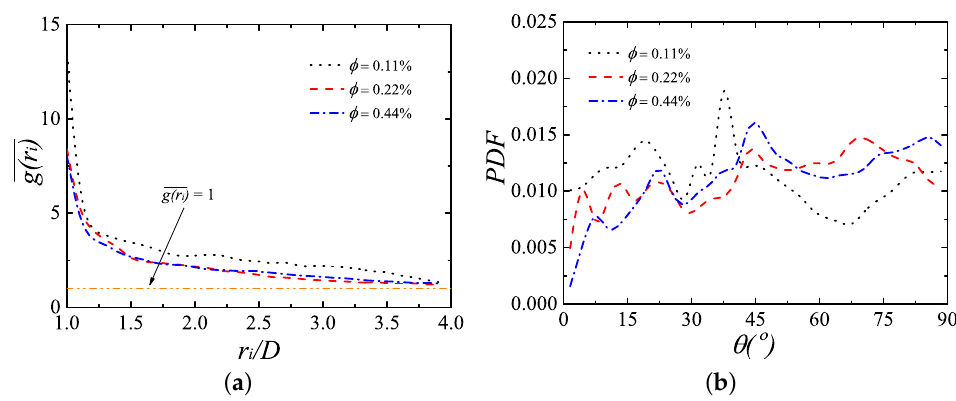
Figure 12. ( a ) The radial distribution functions (RDFs) as a function of center-to-center distance and ( b ) probability density functions (PDFs) of the particle-pair orientation